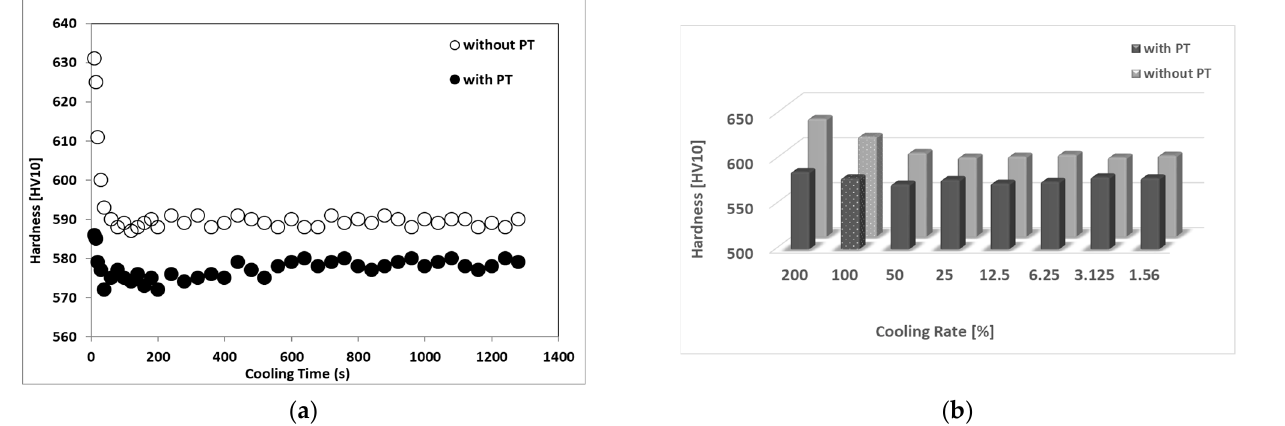
Figure 4. Dependence of hardness (HV10) on various cooling times ( a ) complete set of data ( b ) selected range.